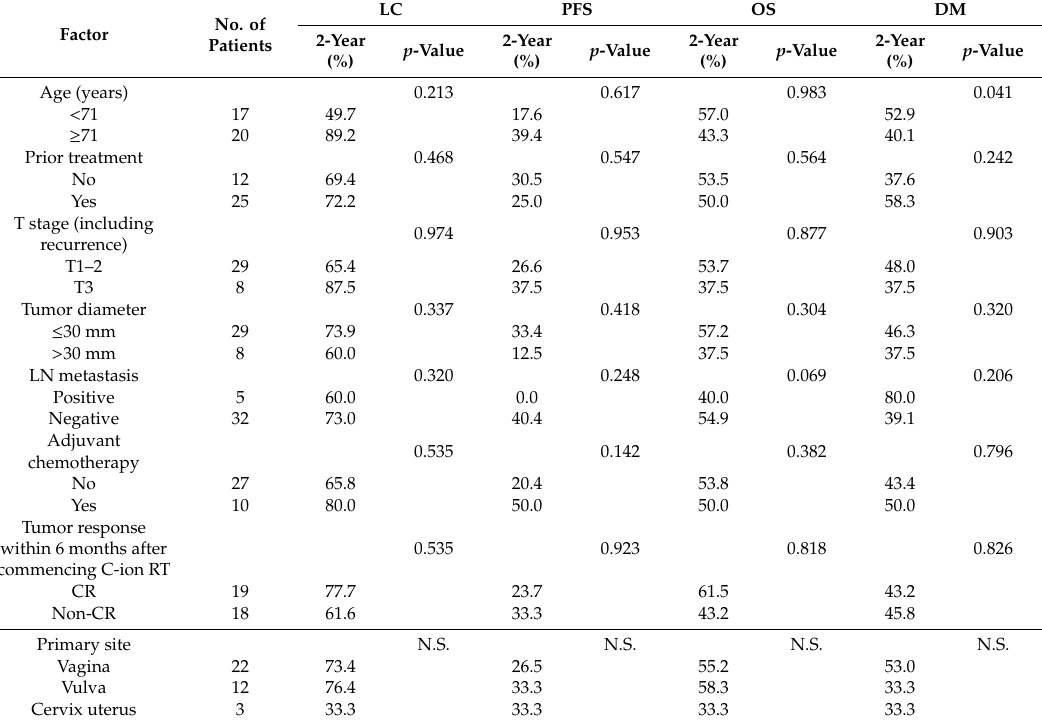
Figure 1. Kaplan–Meier curves of the clinical results. Local control (LC) is shown in red, overall survival (OS) in blue, and progression-free survival (PFS) in green for all 37 patients. The numbers at risk are shown below the figure. Table 2. Assessment of the prognostic factors using univariate